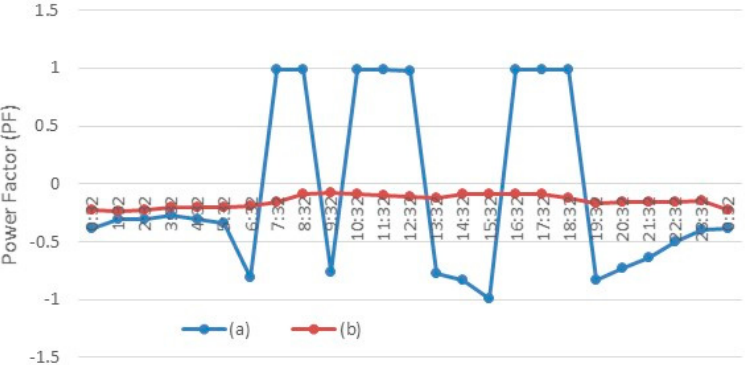
power being very small, less than 0.3 capacitive (Figure 10).